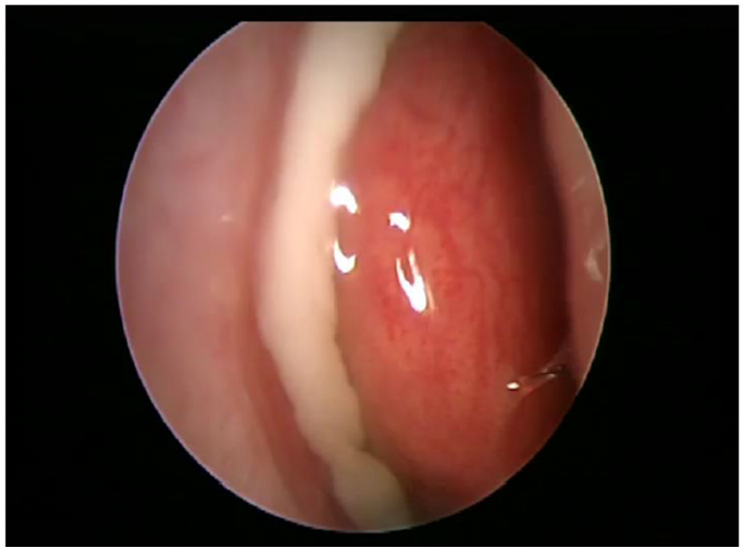
Figure 4. Nasoendoscopic view showing purulent discharge from the right middle meatus. J. Otorhinolaryngol. Hear. Balance Med. 2021 , 2 , x FOR PEER REVIEW